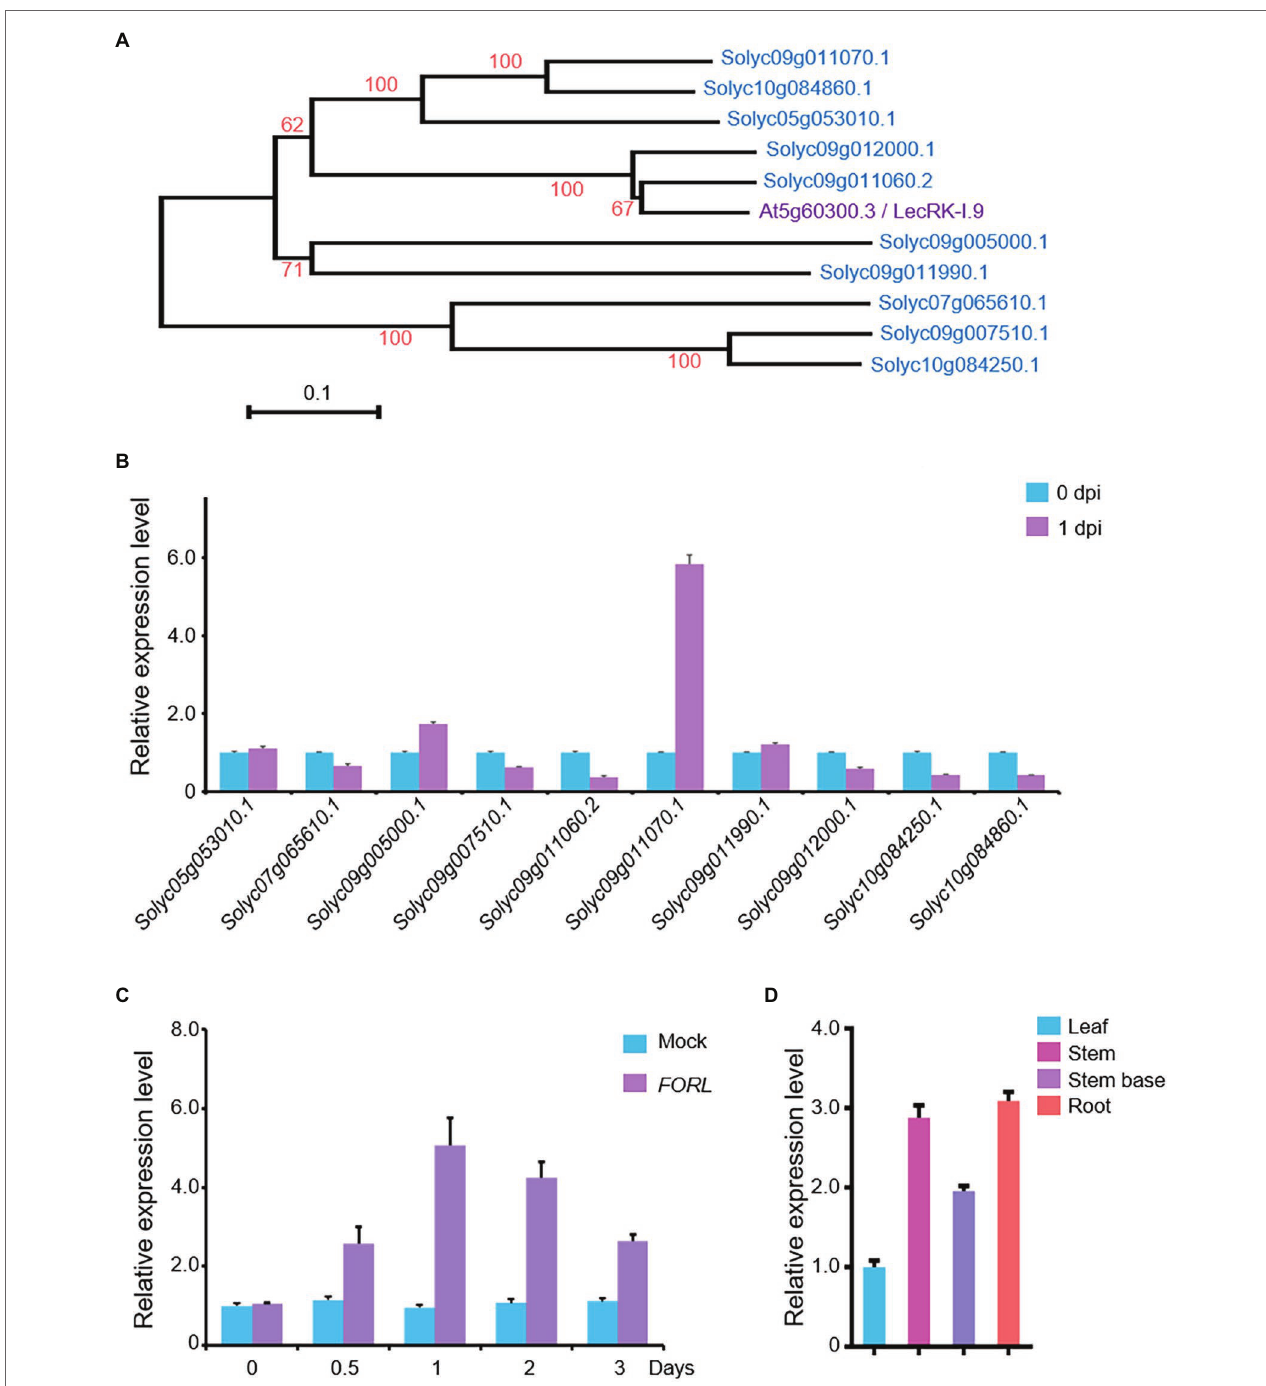
FIGURE 1 | Expression of a LecRK-I.9 homolog in tomato in response to FORL . (A) A phylogenetic tree showing LecRK-I.9 and its homologs in tomato. Based on the predicted amino acid sequences using MEGA 6.0, the scale bar indicates the distance calculated from multiple alignments. (B) Relative expression levels of the LecRK-I.9 homolog following FORL treatment in 10-day-old WT tomato seedlings as measured by qRT-PCR. Total RNA was used for analysis. eEF1 α served as a reference. The WT values at 0 dpi were set to 1. Data are shown as the mean ± standard deviation (SD) from three biological repeats. (C) Induced expression of Solyc09g011070.1 following FORL treatment at different time points. Total RNA was used for qRT-PCR analysis. eEF1 α served as a reference. Ten-day-old WT tomato seedlings were treated with water (Mock) or FORL . Data are shown as the mean ± SD from three biological repeats. (D) Tissue-specific expression of SlLecRK1 in tomato seedlings. Total RNA from the indicated tissues was used for qRT-PCR analysis. eEF1 α served as a reference. Leaf blade values were set to 1. Data are shown as the mean ± SD from three biological